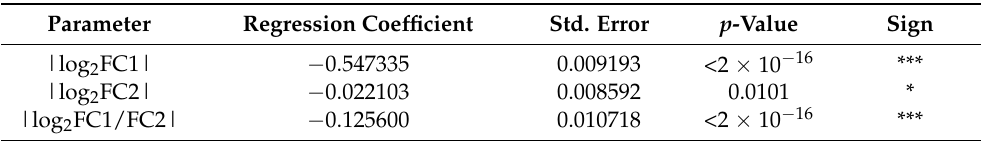
Table 1. Logistic regression analysis prediction parameters. |log 2 FC1| is the proportion between the coverage of two alleles for the SNP with an ASB effect; |log 2 FC2|, the same for the position with an ASE effect; |log 2 FC1/FC2| reflects the difference in asymmetry for SNP in independent ChIP- seq and RNA-seq experiments; Sign:significance (* p -value < 0.05; *** p -value < 0.001), dispersion parameter for binomial family was taken to be